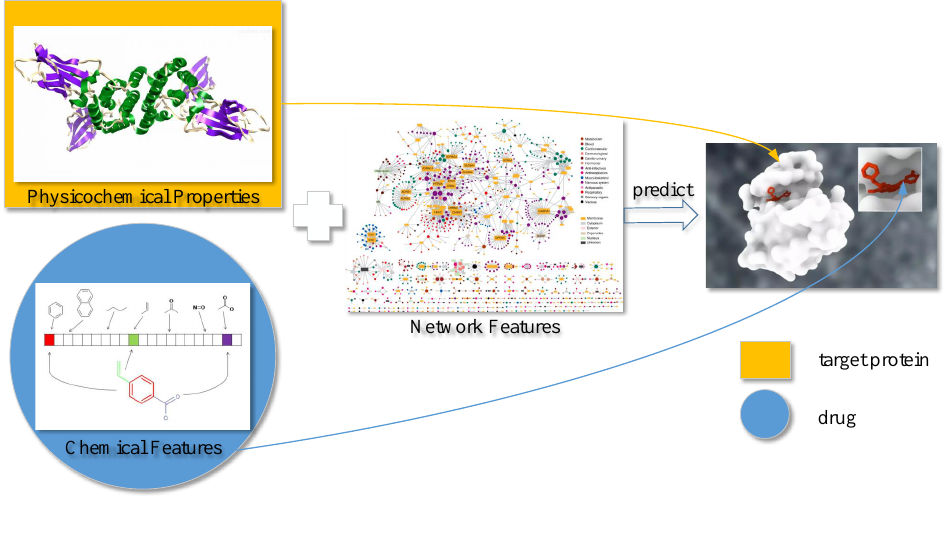
Figure 6. Overview of the drug–target interaction (DTI) prediction.